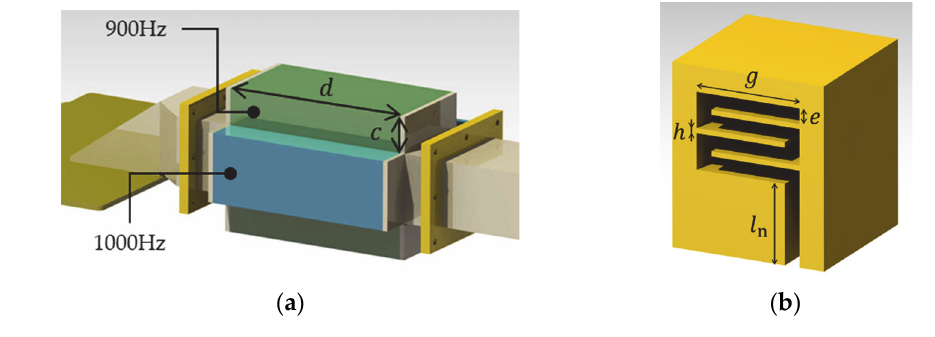
Figure 4. 3D model: ( a ) metasilencer duct; ( b ) unit cell.